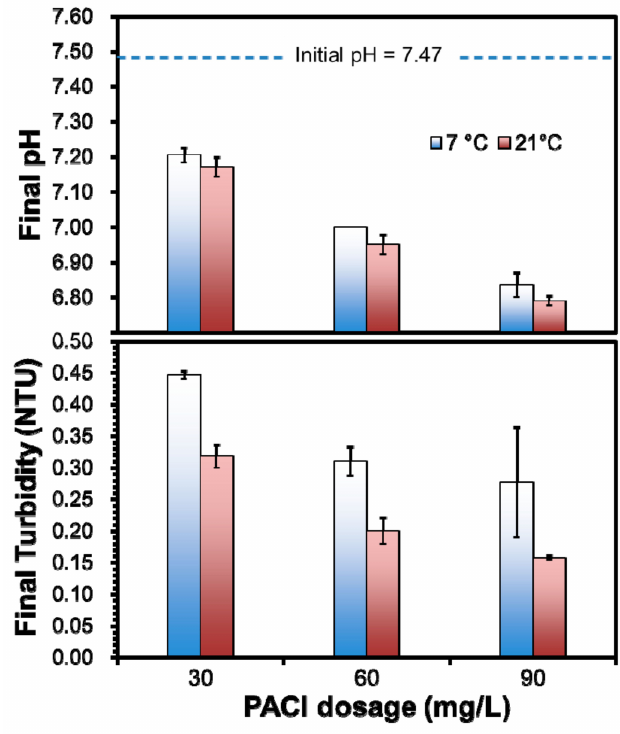
Figure 2. Final pH and turbidity values at three polyaluminum chloride (PACl) dosages and at 7 ◦ C and 21 ◦ C. (Initial pH = 7.47, initial turbidity = 70.00 NTU; data plotted as mean of duplicates and error bars calculated as standard deviation to indicate data